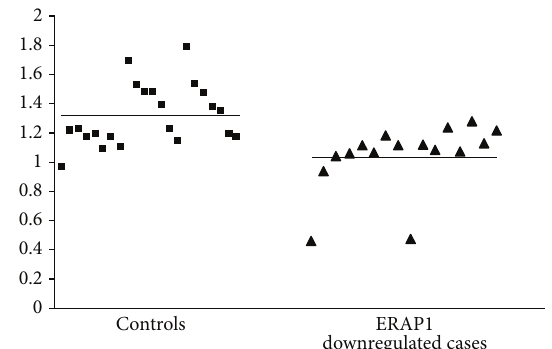
Figure 1: ERAP1 mRNA expression levels relative to the ACTB housekeeping gene in control patients with normal ERAP1 protein expression and cases with ERAP1 protein downregulation. The hori- zontal lines indicate the mean expression levels in the two groups.